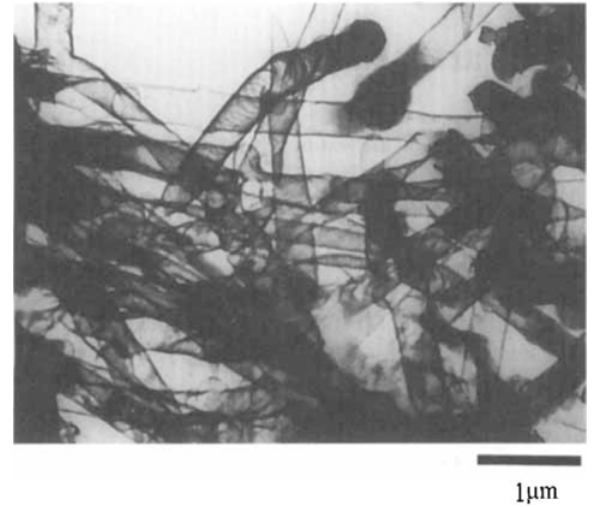
Figure 5. Transmission electron microscopy (TEM) image of the conductive polymer nanotubes fabricated using the AAO template. Reproduced with permission from The International Society of Electrochemistry